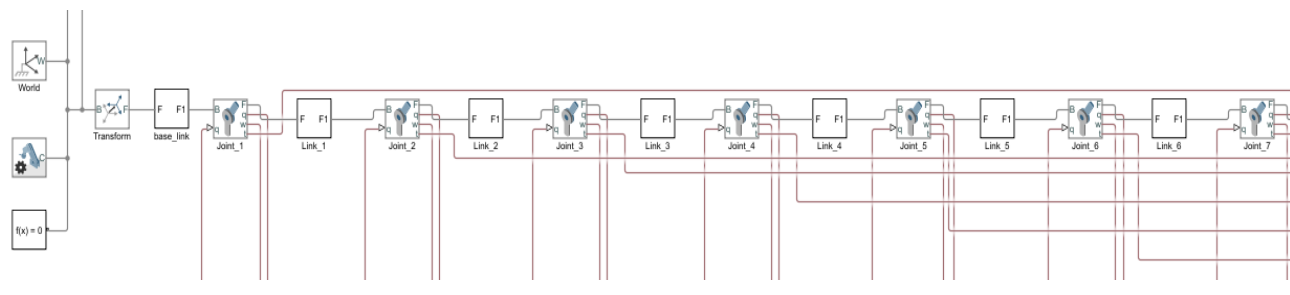
Figure 3. Robot Representation in